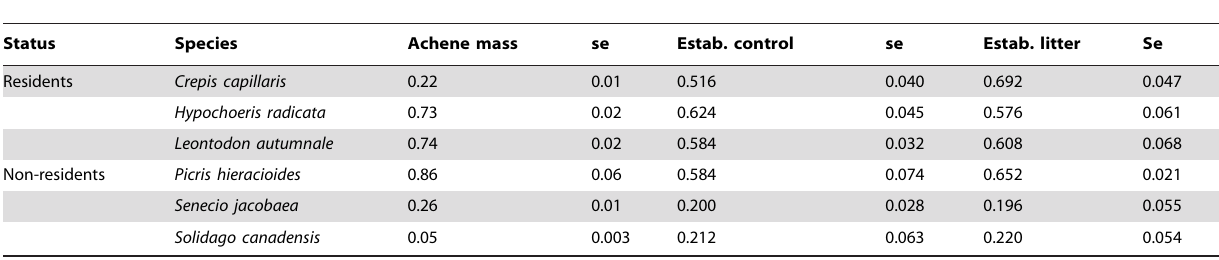
Table 1. Status, achene mass, and establishment in the common